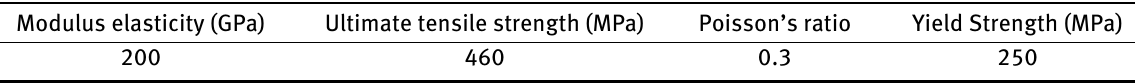
Table 3: Mechanical properties of structural steel